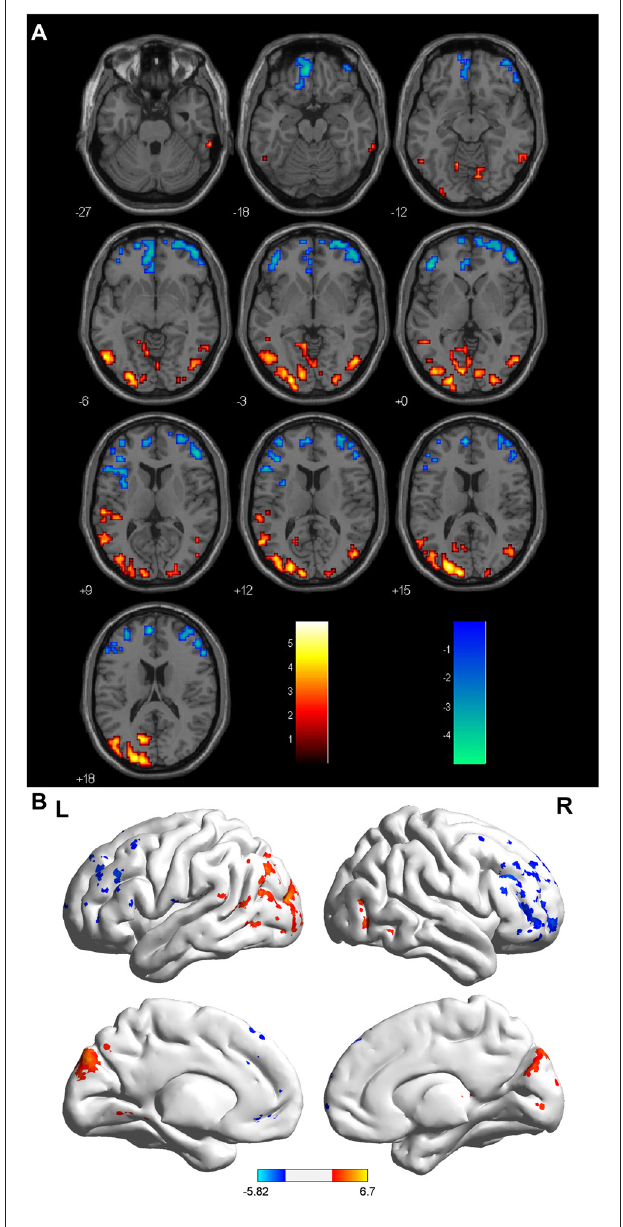
FIGURE 2 | (A,B) ALFF: RED = NC > rON; BLUE = rON > NC. Brain areas showing significant ALFF differences between the relapsing optic neuritis (rON) patients and normal controls. Notes: the different brain regions include the left cuneus/precuneus, right inferior temporal gyrus, left inferior temporal gyrus, bilateral lingual gyrus, right middle occipital gyrus, left superior temporal gyrus, and bilateral inferior and medial frontal gyri. The red areas represent lower ALFF brain regions, and the blue areas represent higher ALFF brain regions (corrected p < 0.01 using AlphaSim). Abbreviations: ON, optic neuritis; ALFF, amplitude of low-frequency fluctuation; L, left; R, right. with the default network (Chadick and Gazzaley, 2011). Our findings implied that the functional adaptations in ON occurred mainly in areas within the frontal-parietal